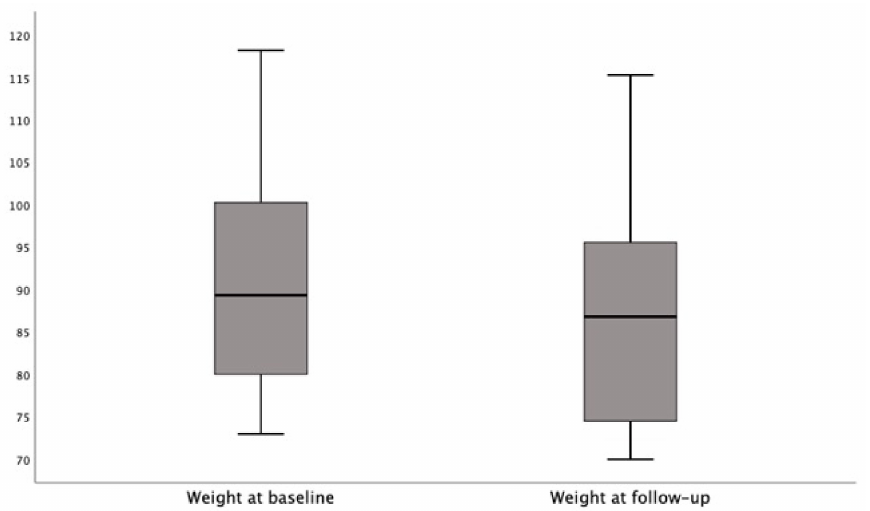
Figure 2. The follow-up weight medians were significantly lower than the baseline medians in participants on FEHC diet.